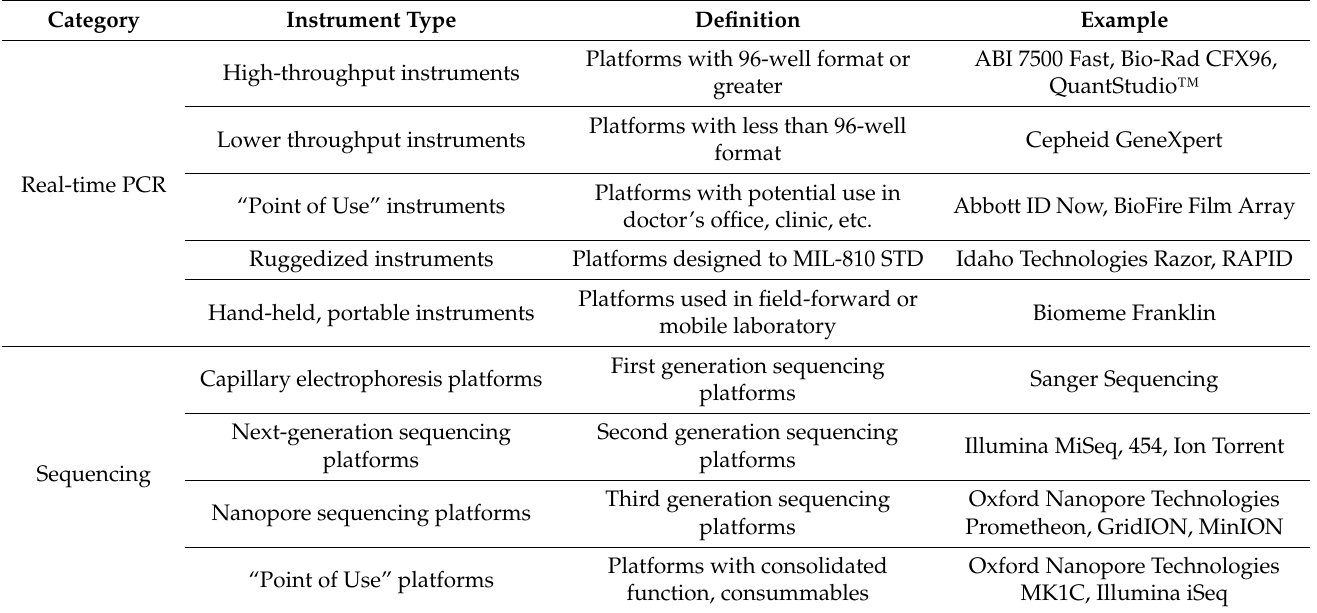
Table 3. Instrument Categories. The real-time PCR instrument types were based on throughput and portability, and the sequencing instruments were based on sequencing platform